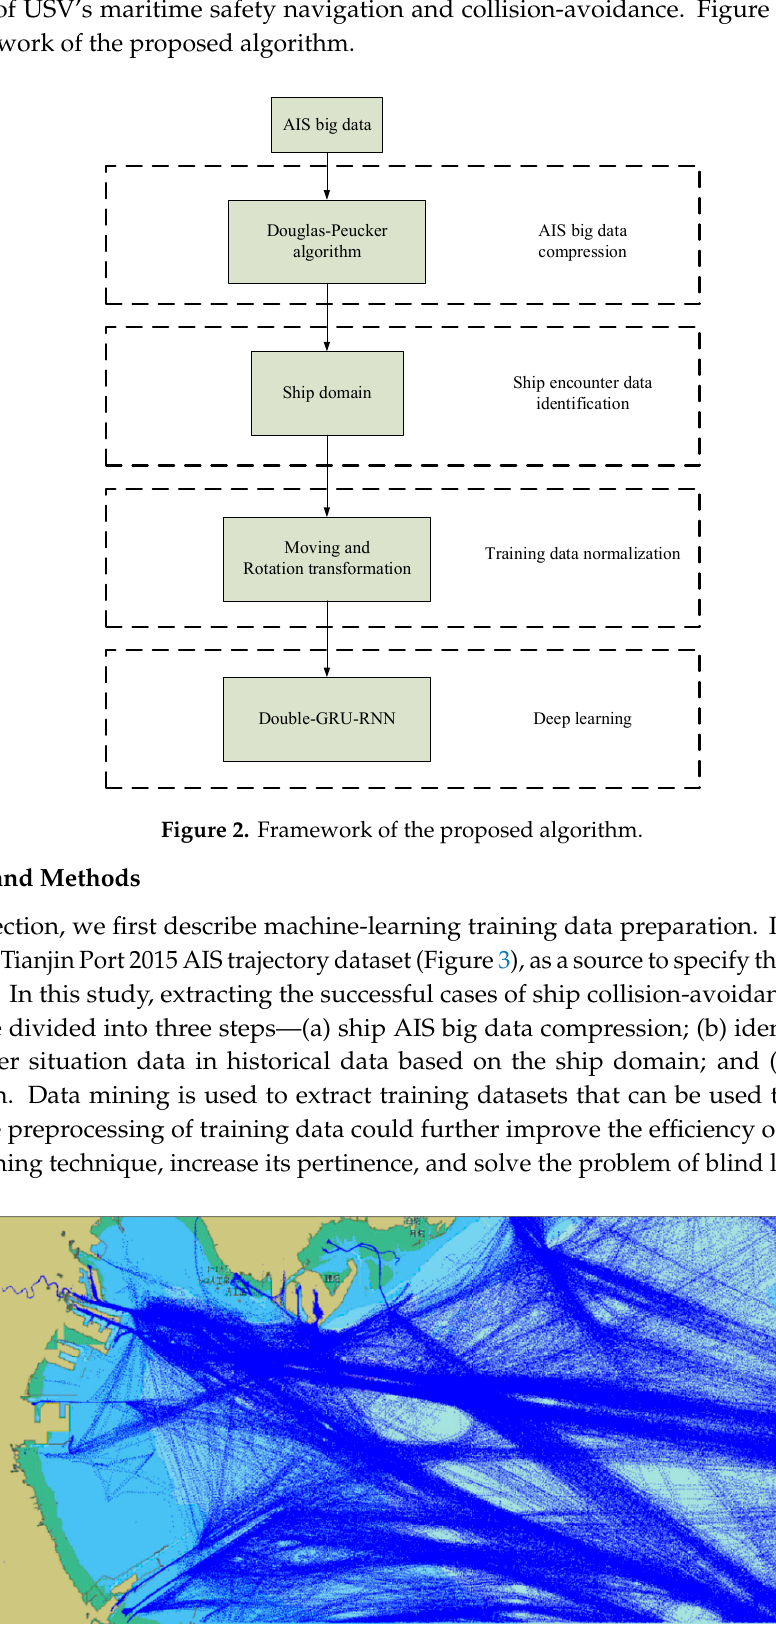
Figure 3. Tianjin AIS data trajectories.